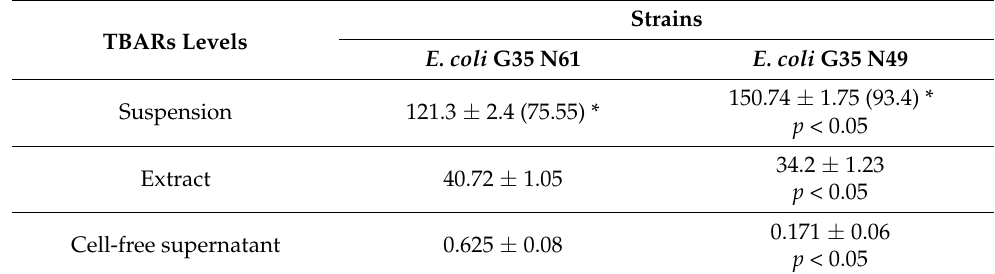
Table 2. Shifts in thiobarbituric acid-reactive substances ( TBARs ) levels ( µ g/mg protein)